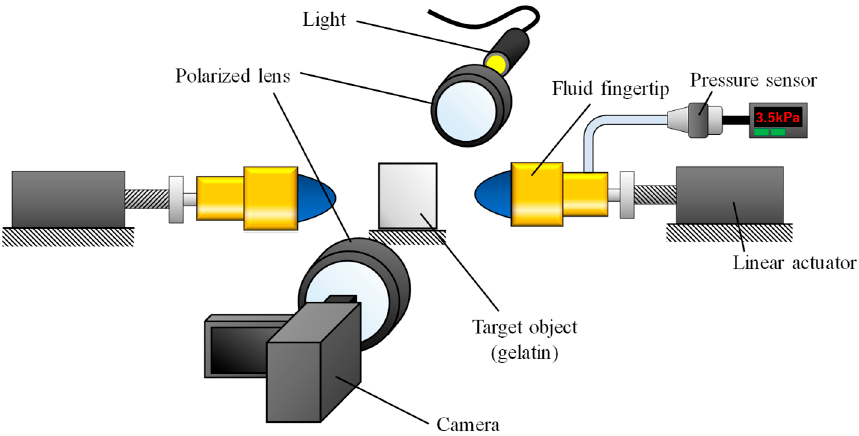
Figure 2. Schematic view of the experimental setup for the compression test with photoelastic imaging.